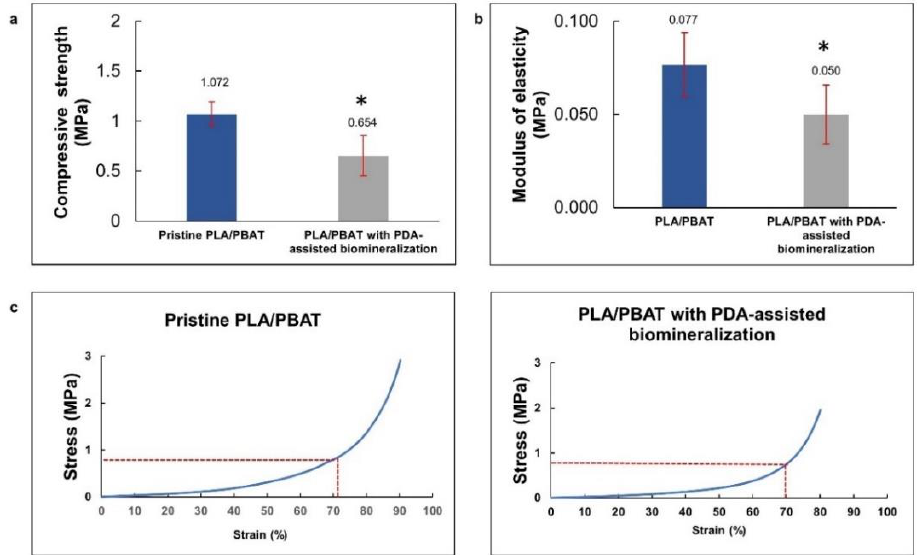
Figure 7. The average compressive stress ( a ) and average modulus of elasticity ( b ) of PLA/PBAT scaffold and PLA/PBAT scaffold with PDA-assisted biomineralization. The difference in number of asterisks represents statistical significance ( p ≤ 0.05). The representative stress – strain curves for pristine PLA/PBAT scaffold and PLA/PBAT scaffold with PDA-assisted biomineralization are exhibited ( c ).